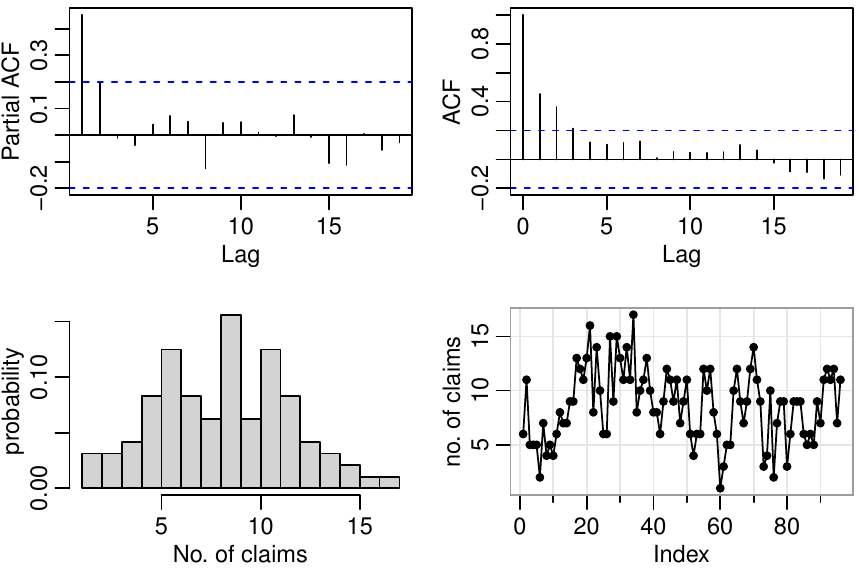
Figure 6. PACF, ACF, histogram and time series plot for the number of claims dataset. The parameter estimates, modelling adequacy criteria, theoretical mean, variance and DI of the fitted INAR(1) process were recorded in Table 13. Since the INAR(1)DPsL process had lesser values for -L, AIC and BIC statistics than those of the INAR(1)DTPL, INAR(1)NPWE, INAR(1)PL and INAR(1)G processes, the INAR(1)DPsL process provided better fits than the competitors. Additionally, the obtained DI value of the